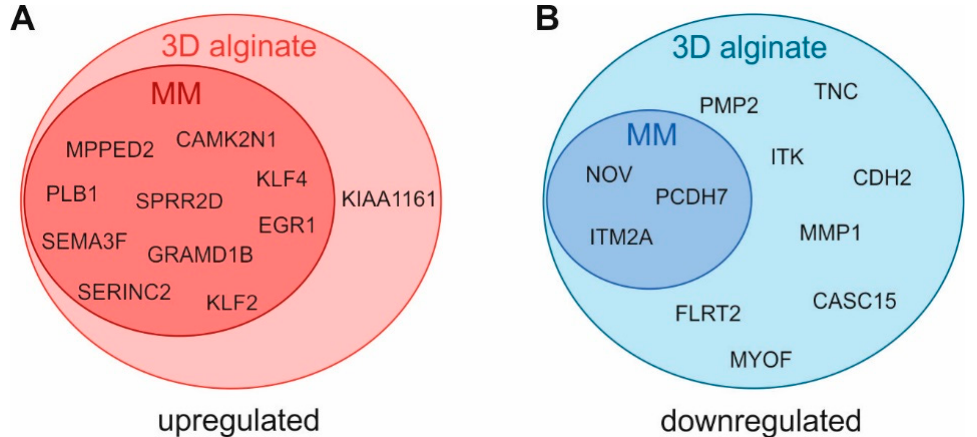
Figure 4. Overlap of significantly deregulated genes in 3D alginate vs. 2D with differentially expressed genes in melanoma (MM) vs. melanocytes (NHEM). ( A ) Genes upregulated in MM and/or 3D alginate. ( B ) Genes downregulated in MM and/or 3D alginate.